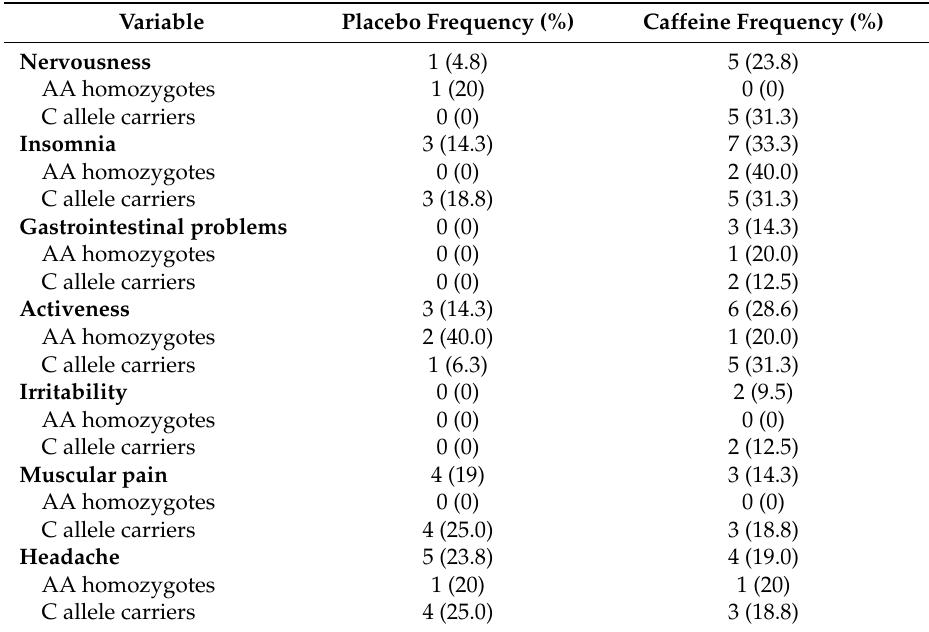
Table 3. Prevalence of side effects with the ingestion of 3 mg · kg − 1 of caffeine or a placebo for AA homozygotes and C-allele